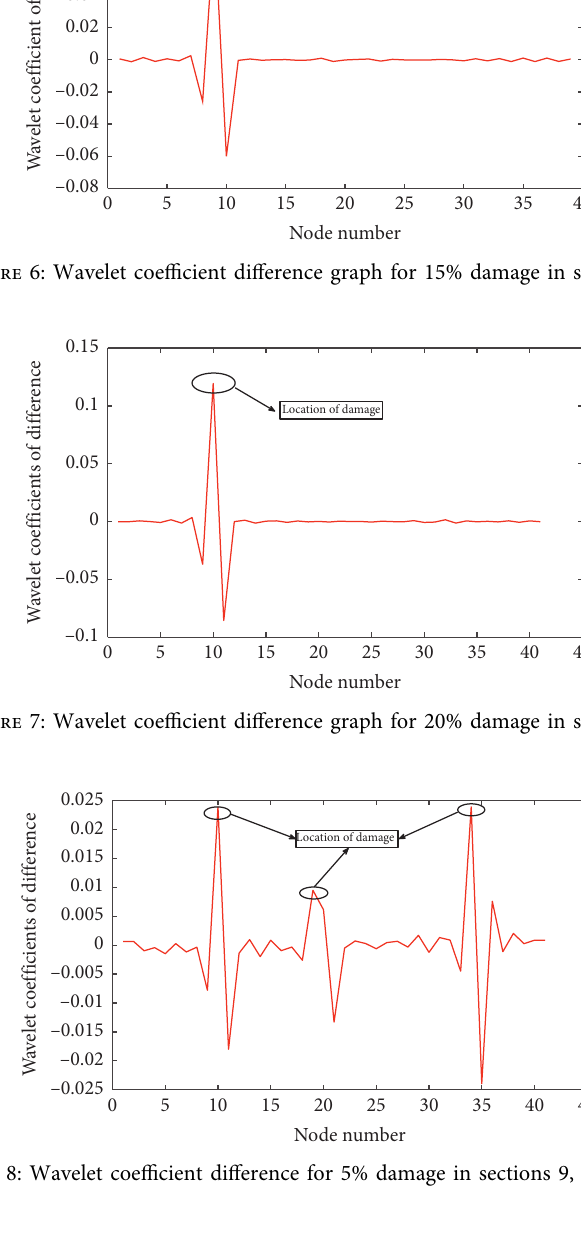
Figure 8: Wavelet coefficient difference for 5% damage in sections 9, 19, and